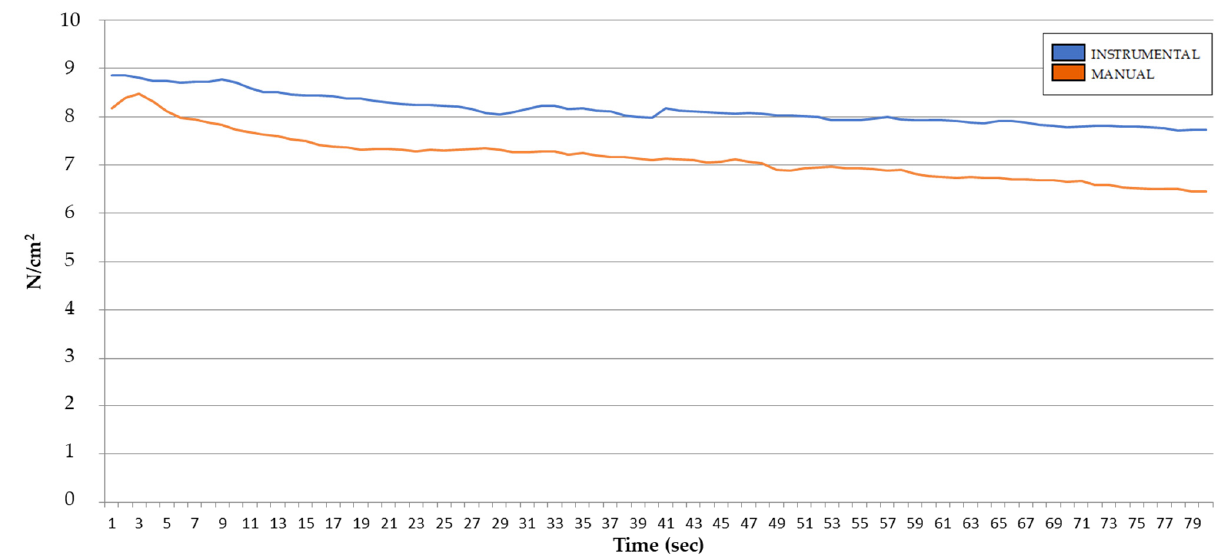
Figure 3. Sequence of pressure exerted throughout the duration of the technique (mean: N/cm 2 /s) with the instrument and manually. Table 3. Comparison of pressure exerted (N/cm 2 ) at 5-s interval between groups. Table 2. Comparison of the mean global pressure ( n /cm 2 ). Interval